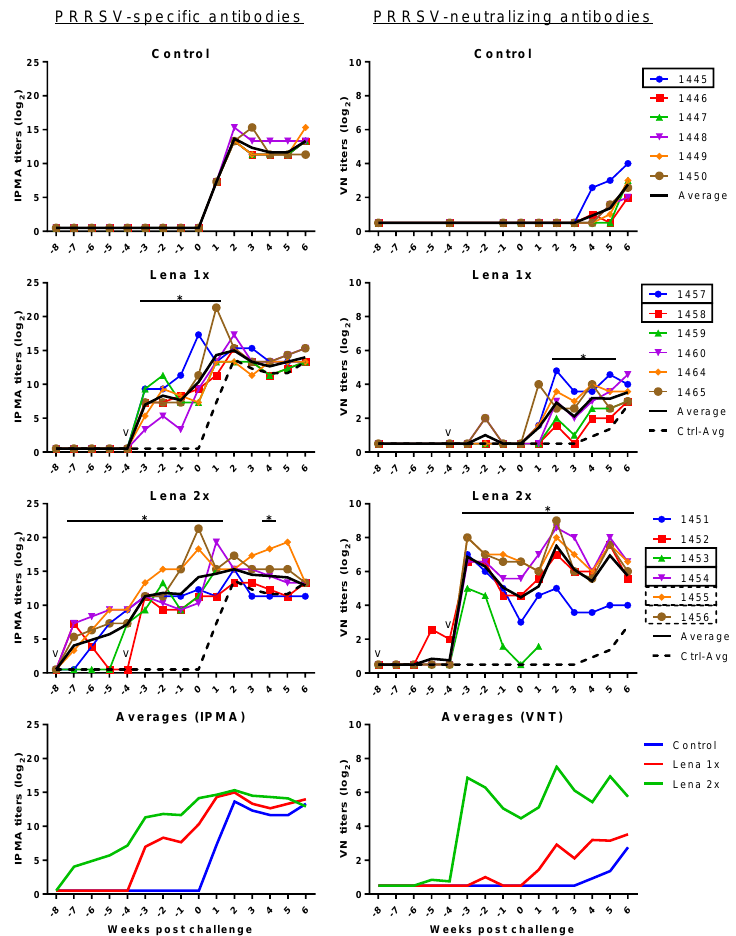
Figure 4. PRRSV-specific IPMA (left) and VN (right) antibodies before and after challenge 10 5 TCID 50 PRRSV Lena. Control pigs received two injections of PBS in adjuvant, at eight and four weeks before the challenge. Group “Lena 1x” was vaccinated once, four weeks before the challenge. Group “Lena 2x” received a prime / booster vaccination at eight and four weeks before the challenge. PRRSV-specific antibodies were detected by IPMA. PRRSV-neutralizing antibodies were detected by a virus neutralization assay (VNT). Colored lines with symbols represent individual pigs. Solid black lines represent the average of each group and dashed black lines represent the average of the control group. v — vaccination; numbers represent individual pig numbers. Solid rectangles around pig numbers mean they have been used in all ADE experiments, dashed rectangles mean their sera have also been further analyzed, but not in all ADE experiments. Statistical analysis was performed with RM 2-way ANOVA, followed by Tukey’s multiple comparison test. The comparison was: Lena 1x vs. Control, and Lena 2x vs. Control. p < 0.05 was considered statistically significant and is represented by